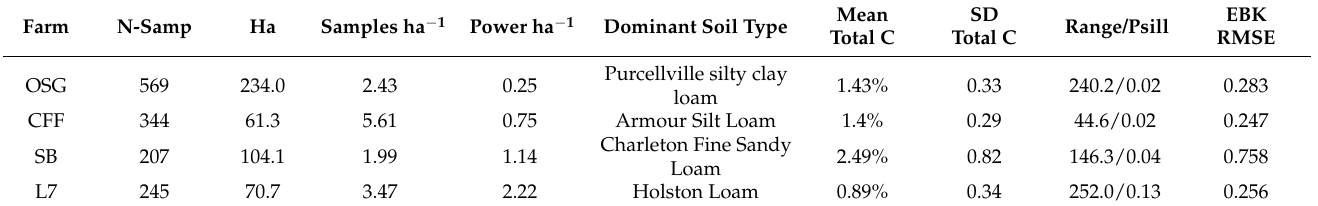
Table 2. Summary statistics across sites including sample intensity, soil type, range/sill from semi- variogram, and interpolation error.